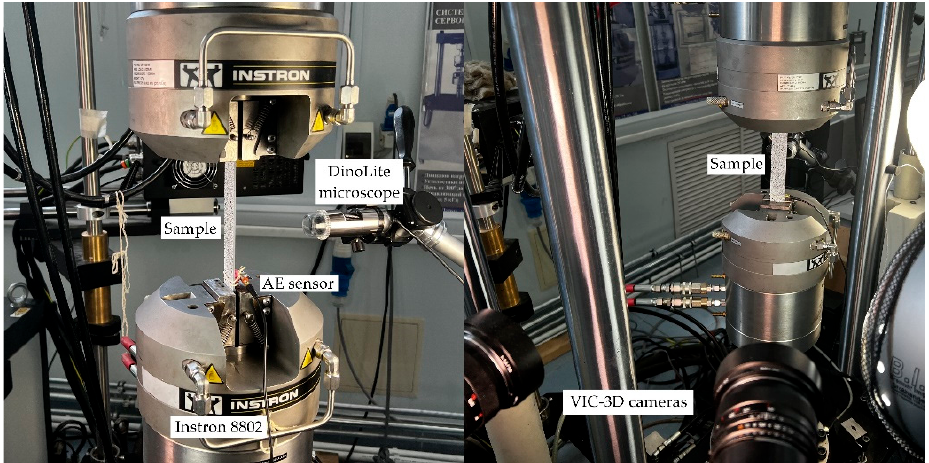
Figure 1. Sample in the testing machine grips and the diagnostic systems.